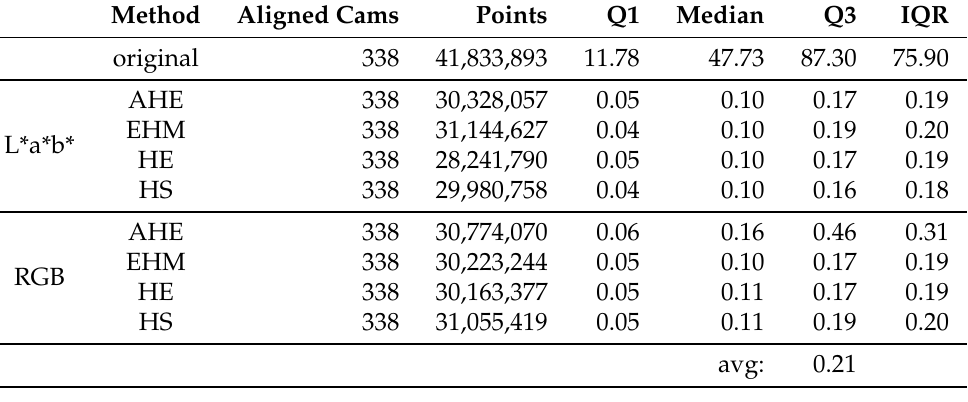
Table 3. Number of points and statistical measures for the reconstruction of the castle in Nowy Wisnicz.